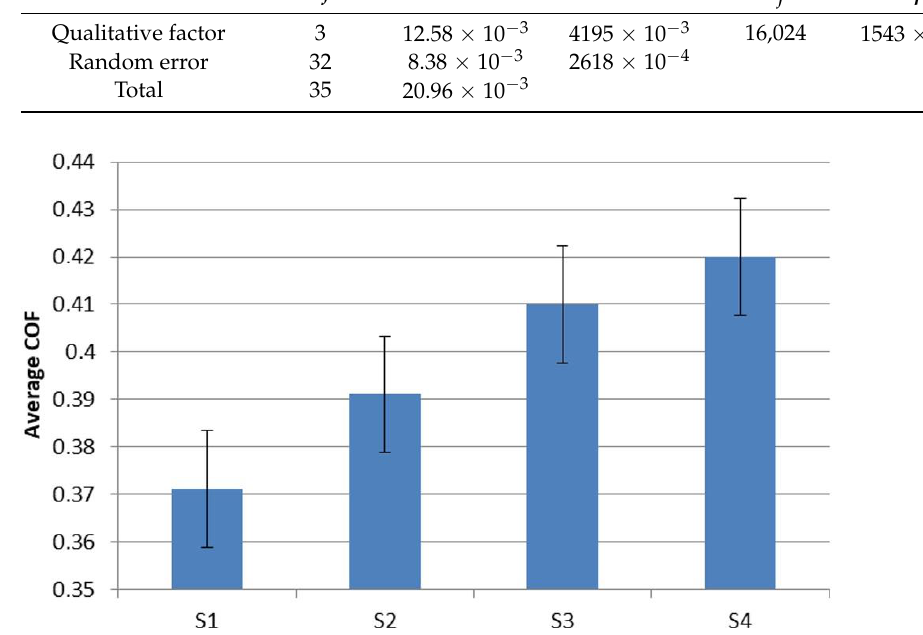
Figure 7. Expected marginal means, current effect: F(3, 32) = 16,024, p = 1543 × 10 − 6 , decomposition of effective hypotheses, vertical bars represent 0.95 confidence interval.